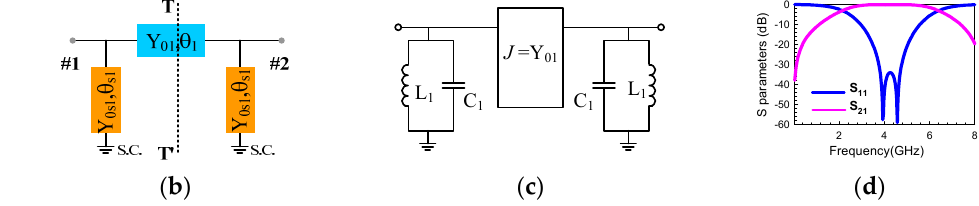
Figure 2. ( a ) A bandpass filter circuit with short-circuited stubs ( b ) TL model ( c ) LE model ( d ) frequency response.